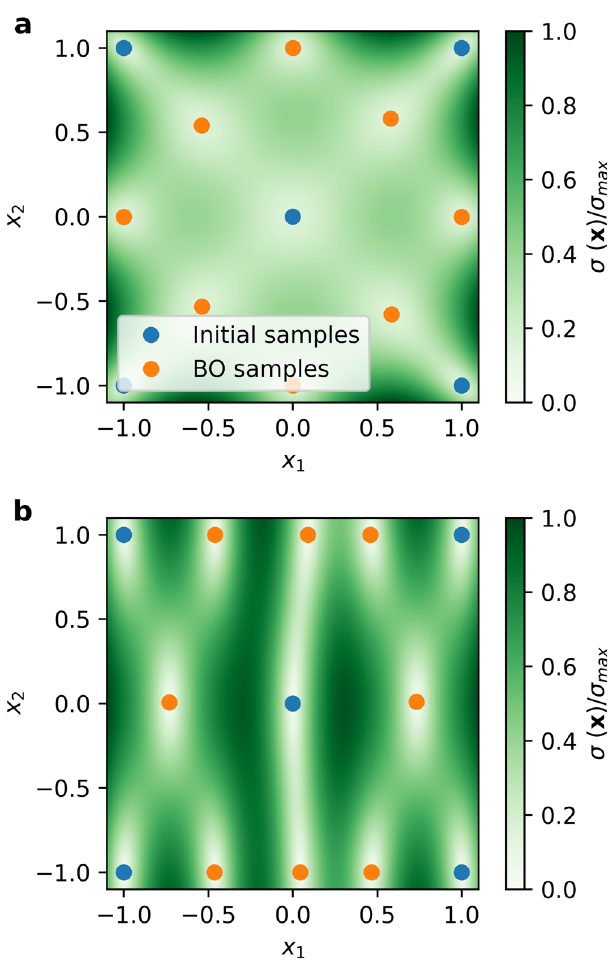
Fig. 1 Plots showing Bayesian optimization (BO) sampling patterns depending on radial basis function (RBF) kernel length scales and using α (x) = σ (x) as the acquisition function. Blue points are initial samples and orange points are sampled during Bayesian optimization. a Length scales for both [ x 1 , x 2 ] set to 1. b Length scales for variables [ x 1 , x 2 ] set to [0.25, Figure 1 shows the effect of kernel length scales on Bayesian optimization when we use this exploratory acquisition function. If the GP kernel has a single length scale, then the acquisition function is maximized at points that are the largest distance away from all previous observations. The sampling algorithm will choose points that form a grid-like pattern in input space, dependent on where initial samples were taken. However, if the length scale is different along each input axis, the exploration algorithm will be biased towards sampling points along the axis associated with the shortest length scale. This leads to an ef fi cient sampling strategy, as more samples are needed to resolve rapidly changing features of the function, while fewer samples are used when the function changes slowly. We use this behavior as a starting point for creating the CPBE acquisition function.